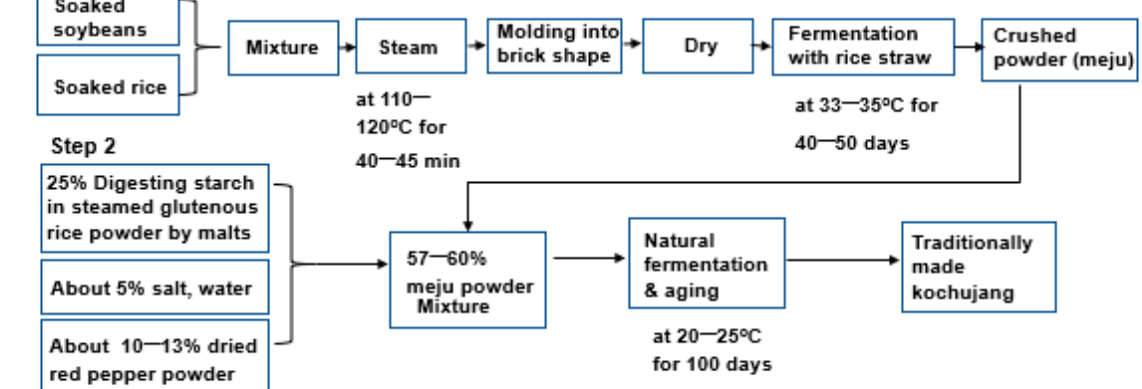
Figure 1. Procedures for traditionally made Kochujang (TMK).